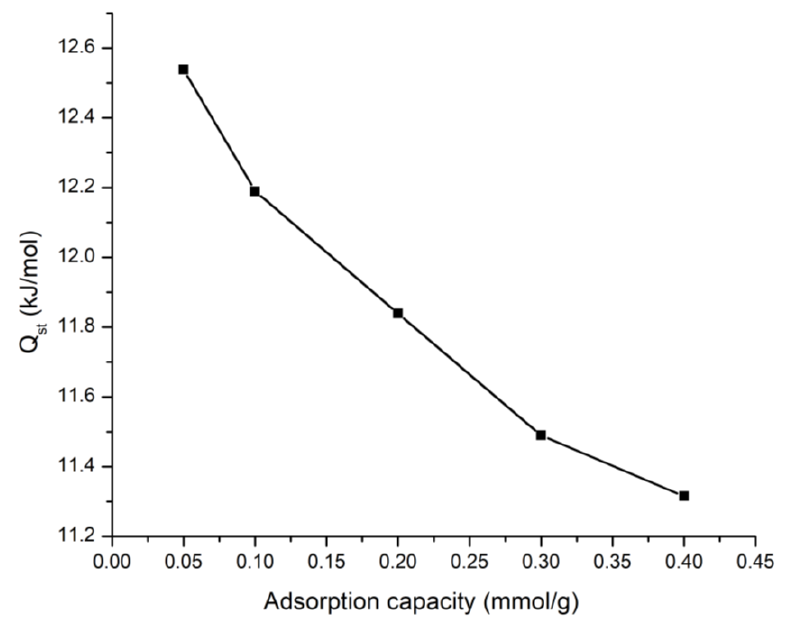
Figure 12. Isosteric heat of CO 2 adsorption on the RSS-IL 800.